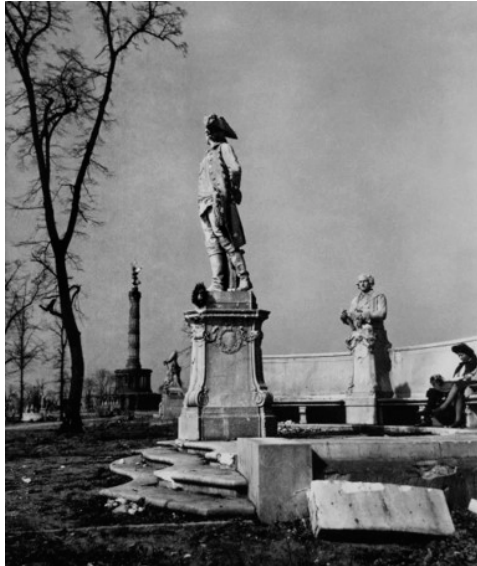
Figure 9. Henry Ries. Denkmäler zur preußischen Geschichte im abgeholtzten Tiergarten, Statue Friedrich des II, im Hintergrund die Siegessäule ( Monuments to Prussian History in the Picked-up Zoo, Statue of Frederick II, in the Background the Victory Column ). 1948. Photograph. © Henry Ries. Deutsches Historisches Museum. Invoice No. Ph2007/4176.31, file PH009319.